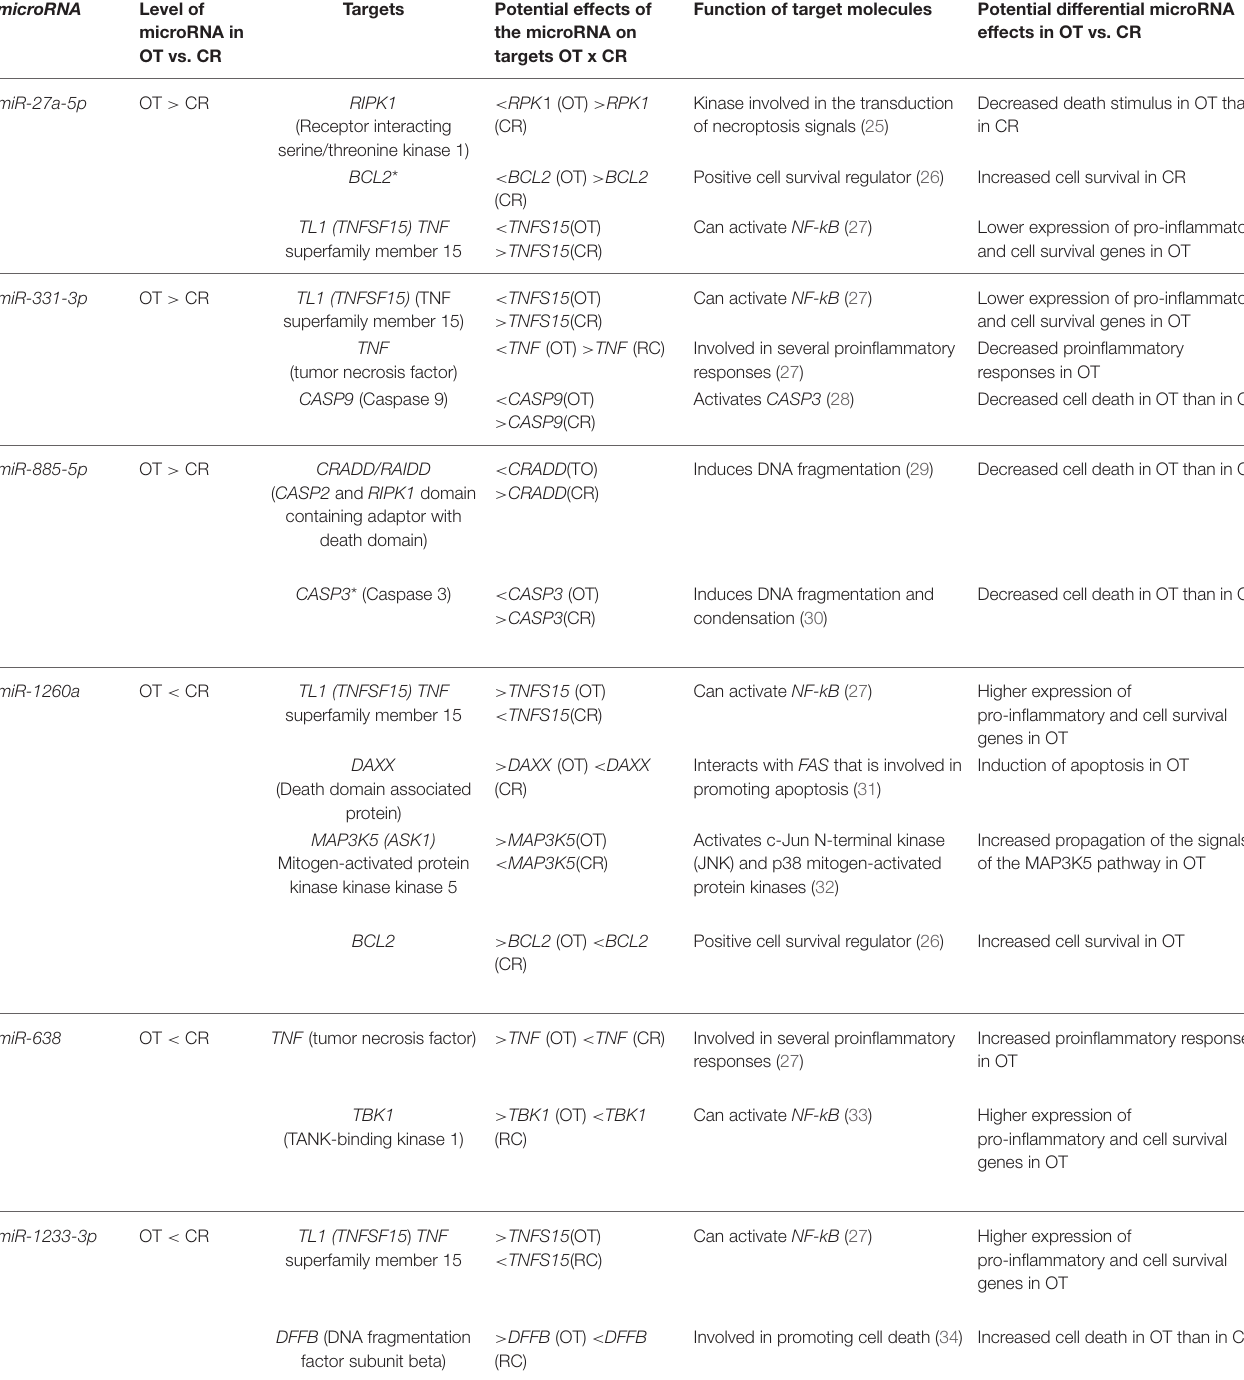
TABLE 3 | Potential effects of the microRNAs comprised in the OT-CR differential profile on the different targets of the death receptor pathway.